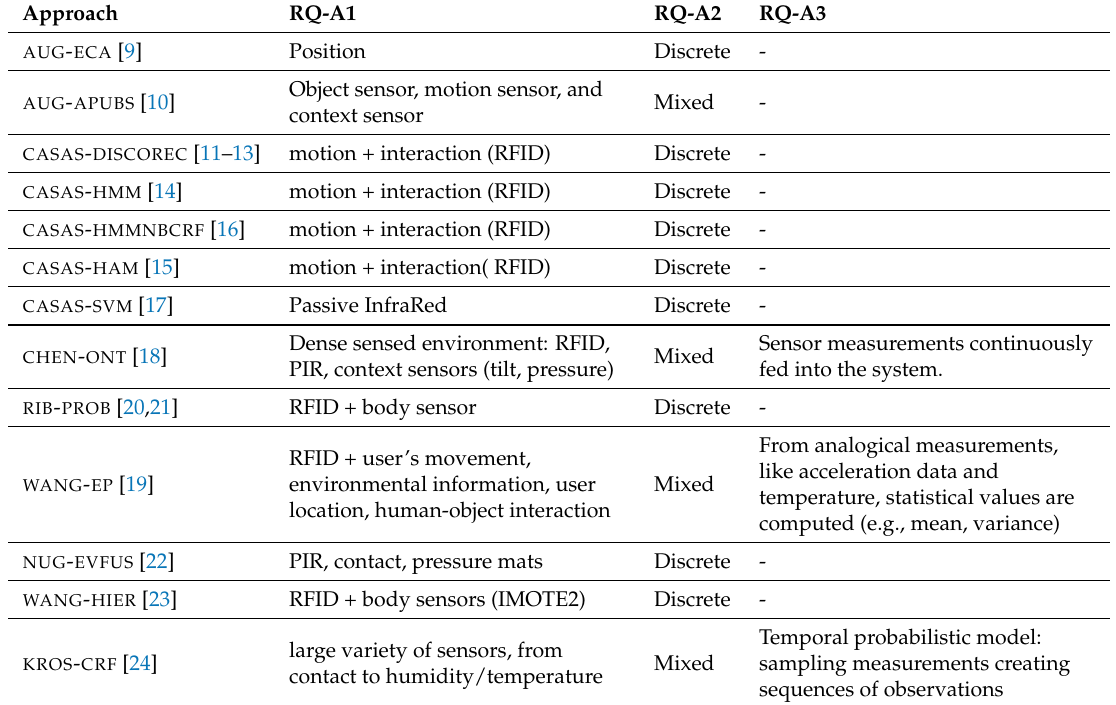
Supported Sensors—RQ-A1: sensors type—RQ-A2: data produced type—RQ-A3: discretization